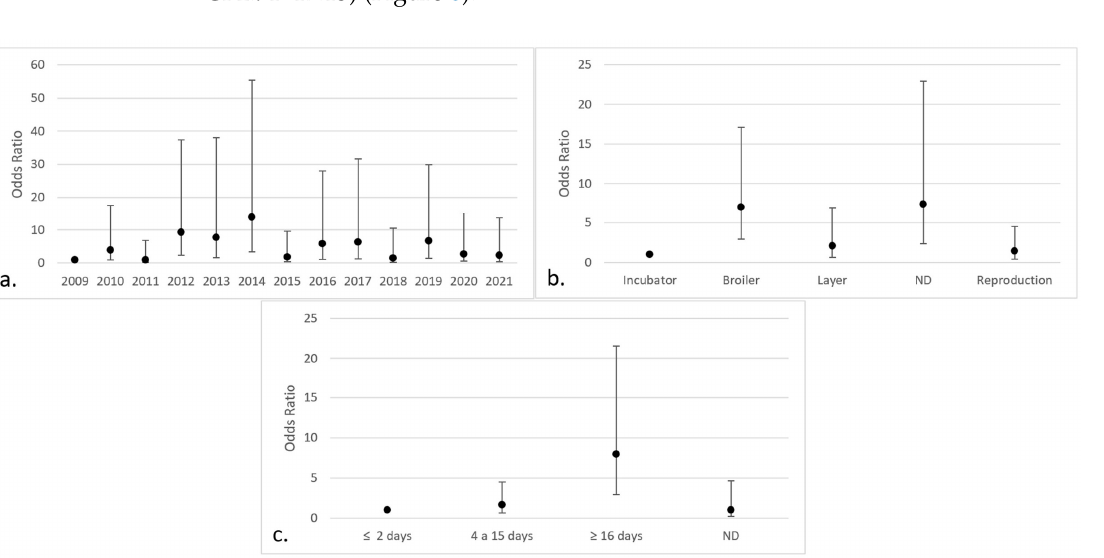
Figure 7. Categories with the highest risk of positive isolates for Aspergillus section Nigri (95% CI) in chicken lungs ( Gallus gallus ) from 2008 to 2021 in the Mycology Laboratory, School of Veterinary Medicine, Universidad Nacional, Costa Rica. ( a ) Productive purpose of the bird; ( b ) county of origin; ( c ) bird breed. ND = non-determinate production purpose; BR/SRF = Barva and San Rafael; CN/NT = counties from the center and north of Alajuela; ND = non-determinate origin and Dota, Santa Ana, Sarapiquí, Turrialba, Turrubares, Upala, Río Cuarto, San Carlos, and Pavas; OR/SNM = Orotina and San Mateo; Cobb X = pure Cobb mixed with Hubb and Ross; Dekalb White = pure Dekalb White mixed with Isa Brown; ND = non-determinate breed and Ross, Redbro, Sasso, Hubbard, and Lohman.